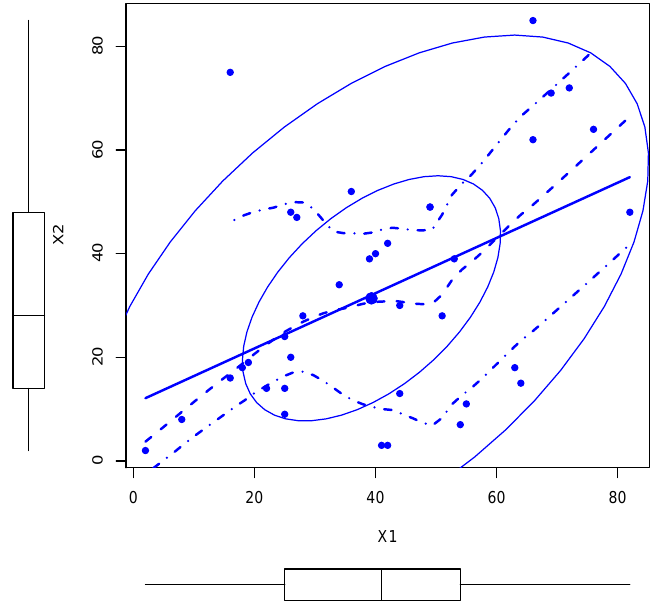
Figure 4. The scatter plot for data set I.